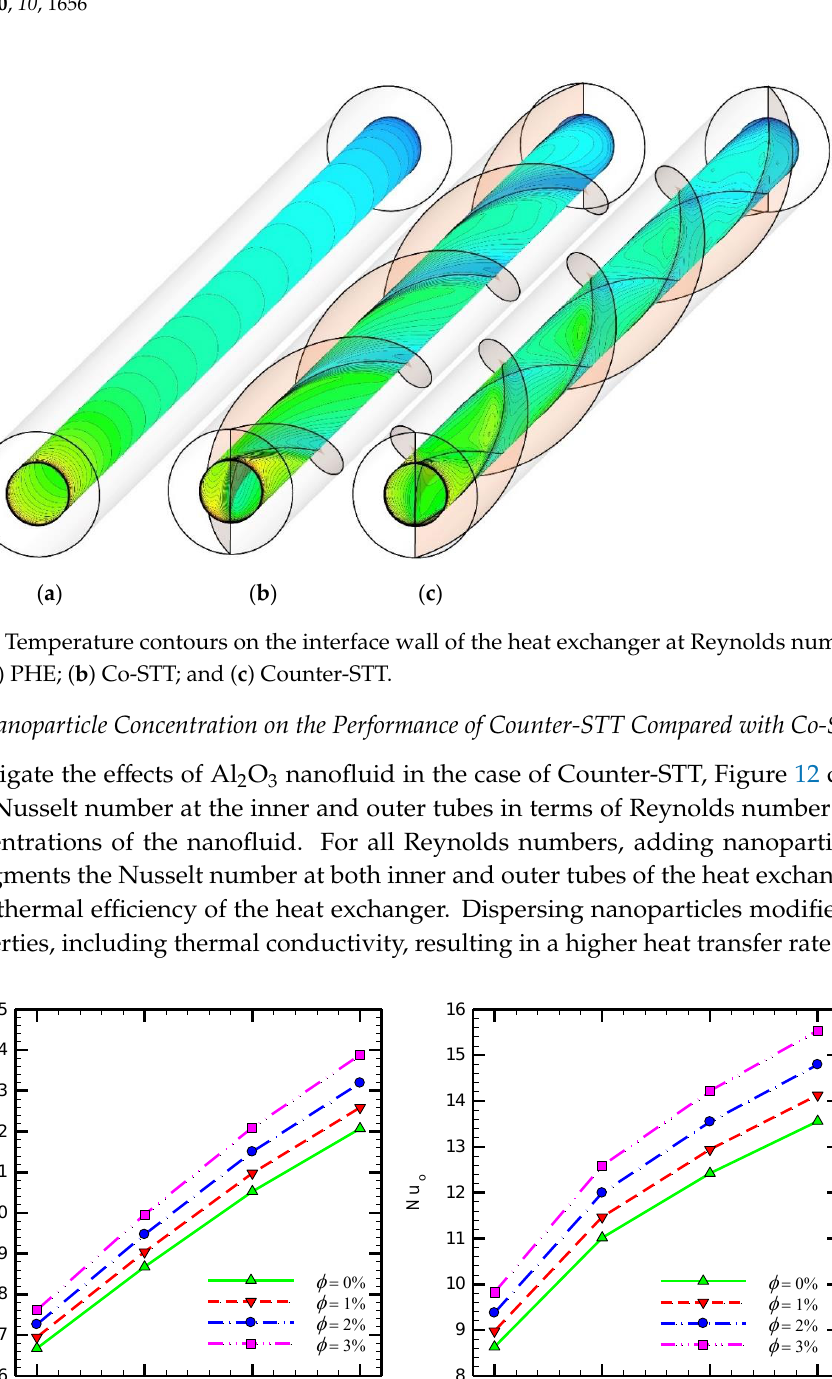
( c ) Figure 10. Cross-sectional temperature contours at Reynolds number of 250 for: ( a ) PHE; ( b ) Co-STT; and ( c ) Counter-STT. Figure 11 illustrates the temperature contour at the interface wall of the heat exchanger for PHE,